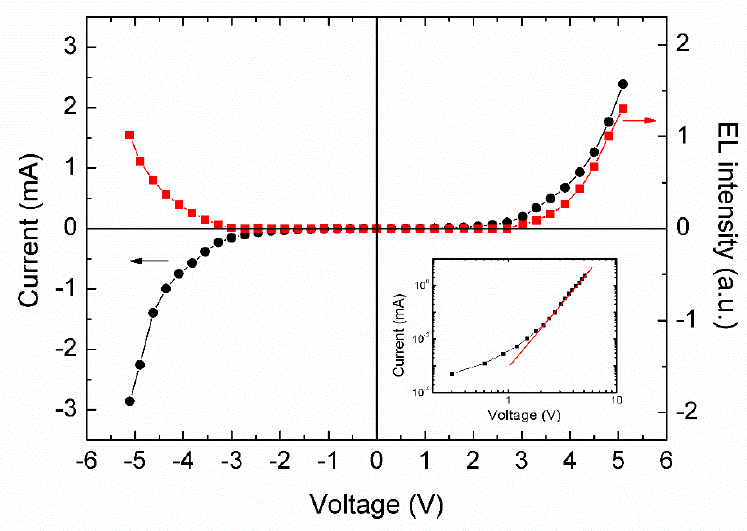
Figure 2. Luminance–current–voltage curves of LEC devices at 250 K, and the fitting results according to the power law are shown in the lower right inset.